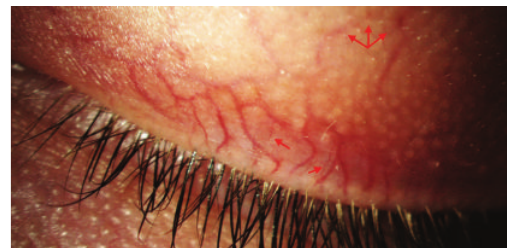
Figure 5: Severe grade of blood vessels tortuosity with presence of microaneurysms and telangiectasia (arrows).